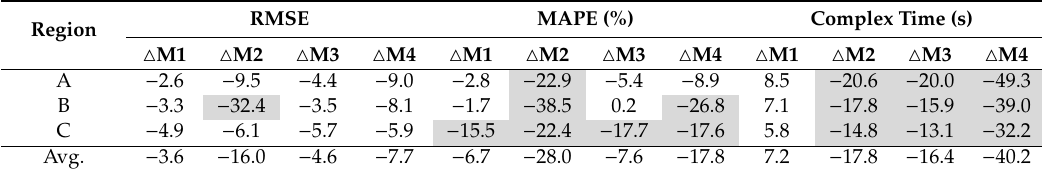
Table 6. Performance analysis of the hybrid model with other models.